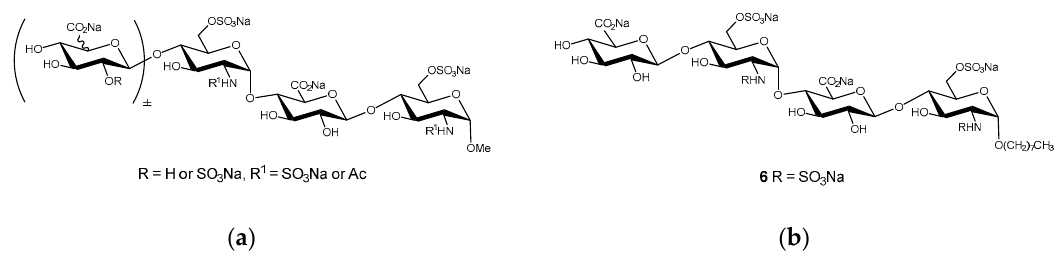
Figure 3. ( a ) Structures of putative heparanase substrates from a library synthesised by Yu and coworkers [59,61]; ( b ) putative heparanase tetrasaccharide substrate synthesised by Tamura and coworkers [60].